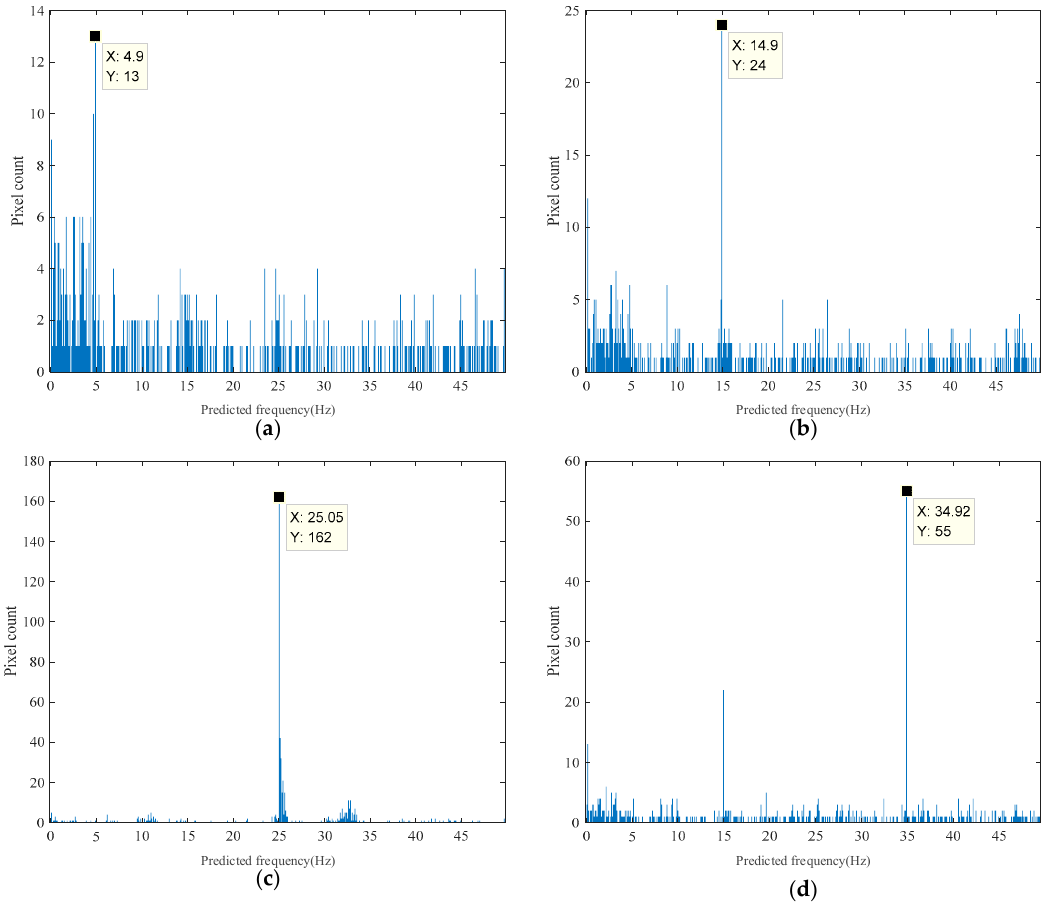
Figure 9. Four representative results of histogram of predicted frequency distribution after edge enhancement: ( a ) 5 Hz excitation result; ( b ) 15 Hz excitation result; ( c ) 25 Hz excitation result; ( d ) 35 Hz excitation result.